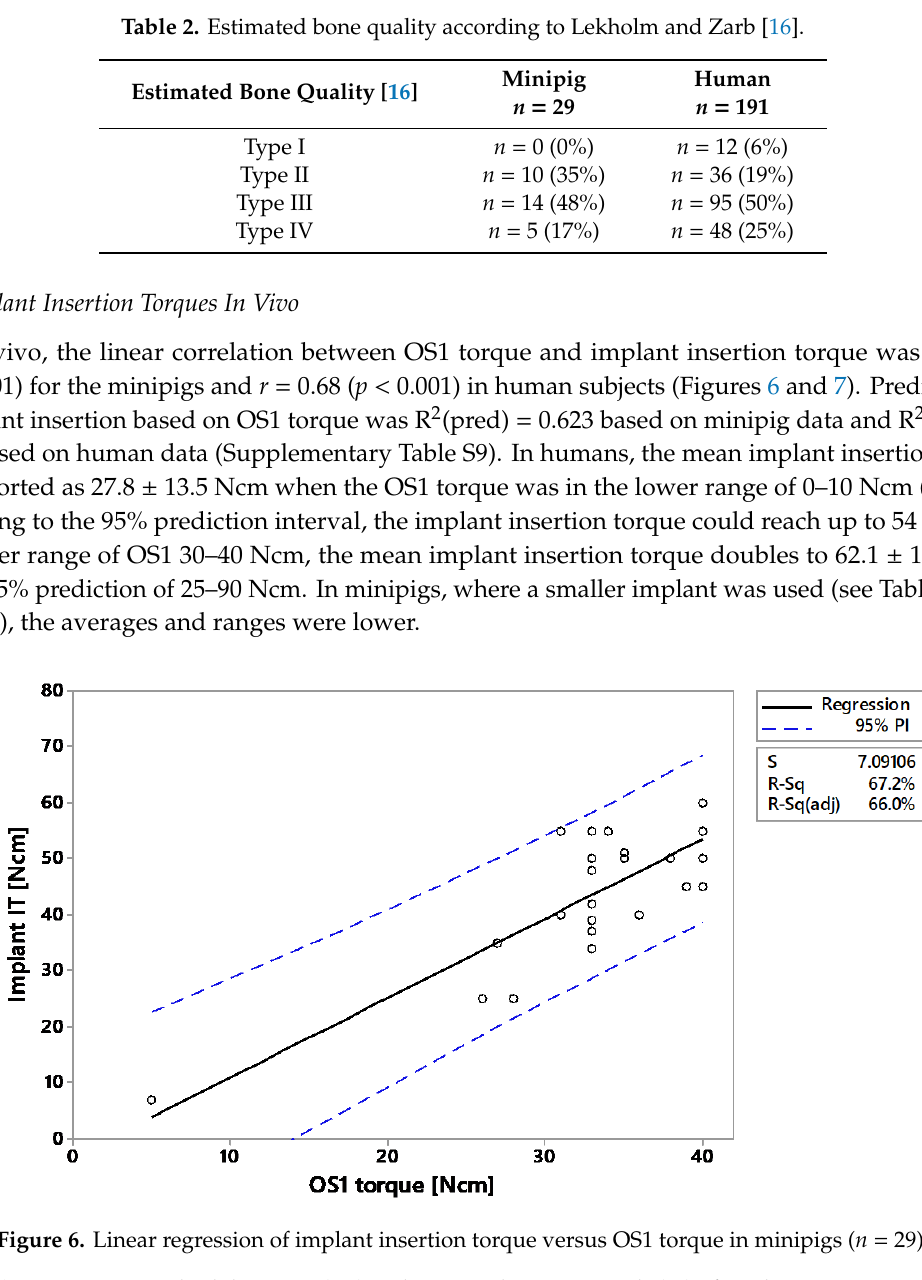
Table 2. Estimated bone quality according to Lekholm and Zarb [16].